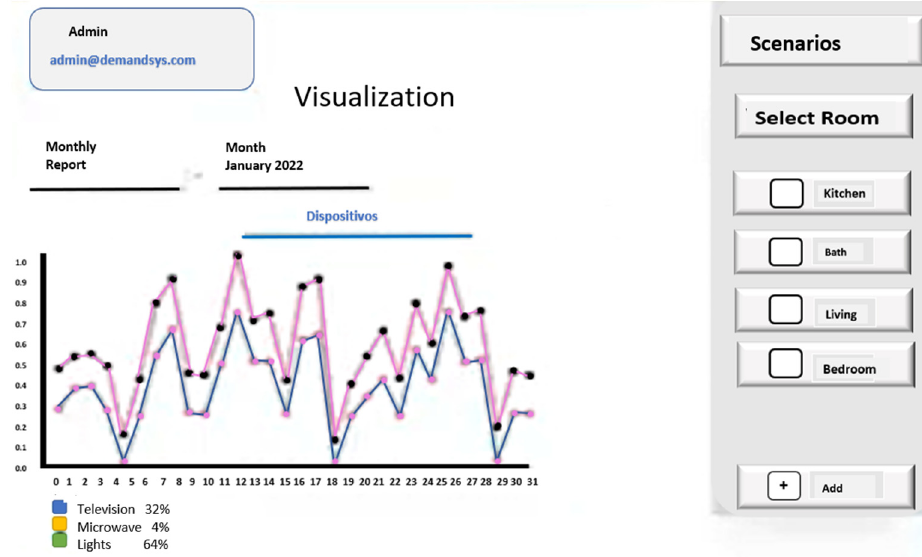
Figure 9. Actual consumption vs. proposed consumption.